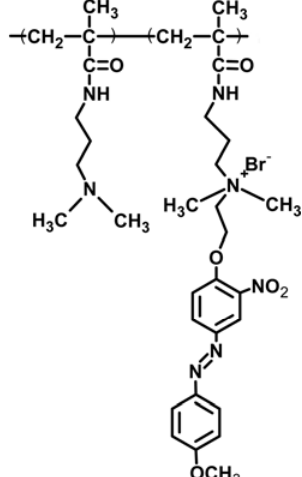
Figure 14. Polyacrylamide copolymer containing 2-nitro-4’-methoxyazobenzene, PNA, used in